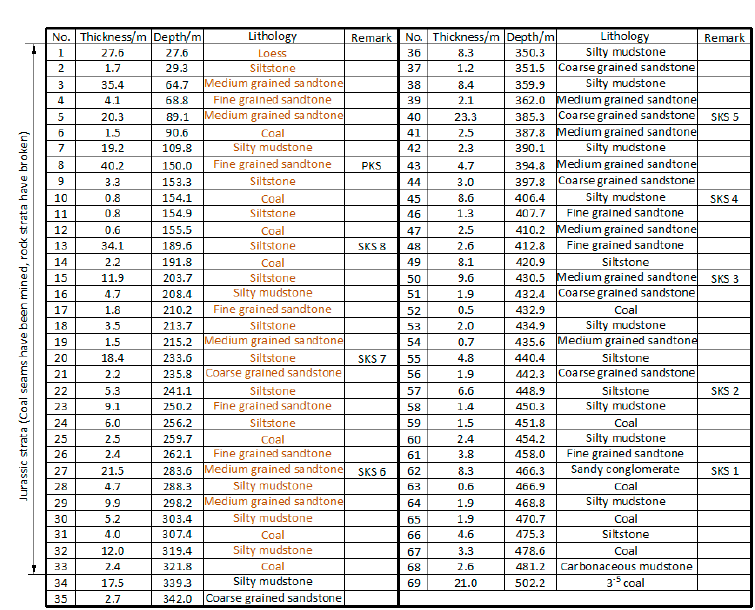
Figure 2. Stratigraphical column obtained from the detective